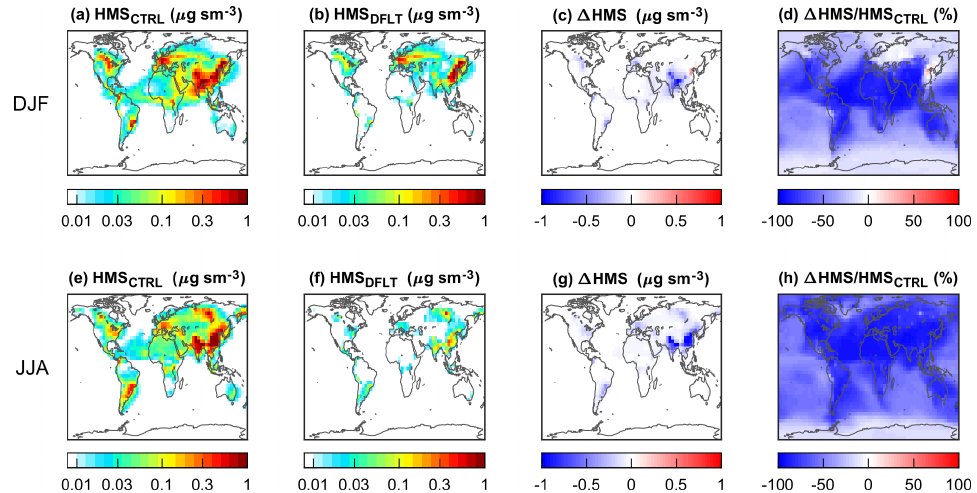
Figure 6. Surface concentrations of HMS from the control (CTRL) and default (DFLT) simulations in two seasons. Top and bottom panels show results for DJF (December–January–February) and JJA (June–July–August), respectively. (c) is the absolute difference between these two simulations: b − a . (d) is their relative difference: (b/a − 1 ) × 100%. Similarly, (g) is the absolute difference between (e) and (f) : f − e , and (h) the relative difference between them: (f/e − 1 ) × 100%. The color bars in (a) , (b) , (e) , and (f) are not